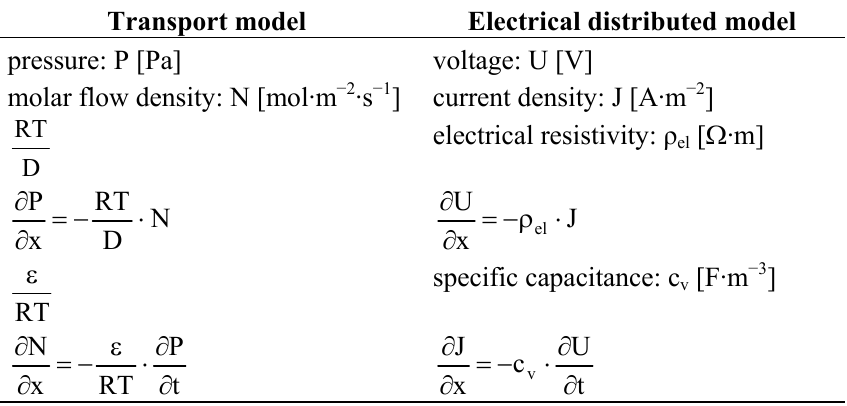
Table 3. Analogy between mechanical and electrical formulations.